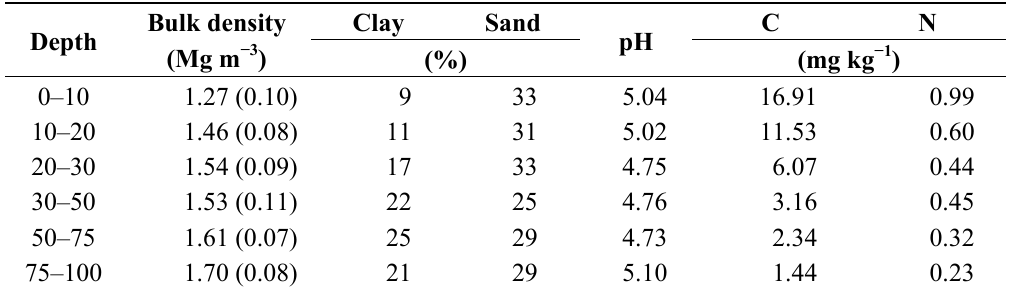
Table 1. General soil characteristics of the study area, a loamy Ultisol in the West Gulf Coastal Plain of the United States. Bulk density means and standard deviations are from n = 72 samples per depth.